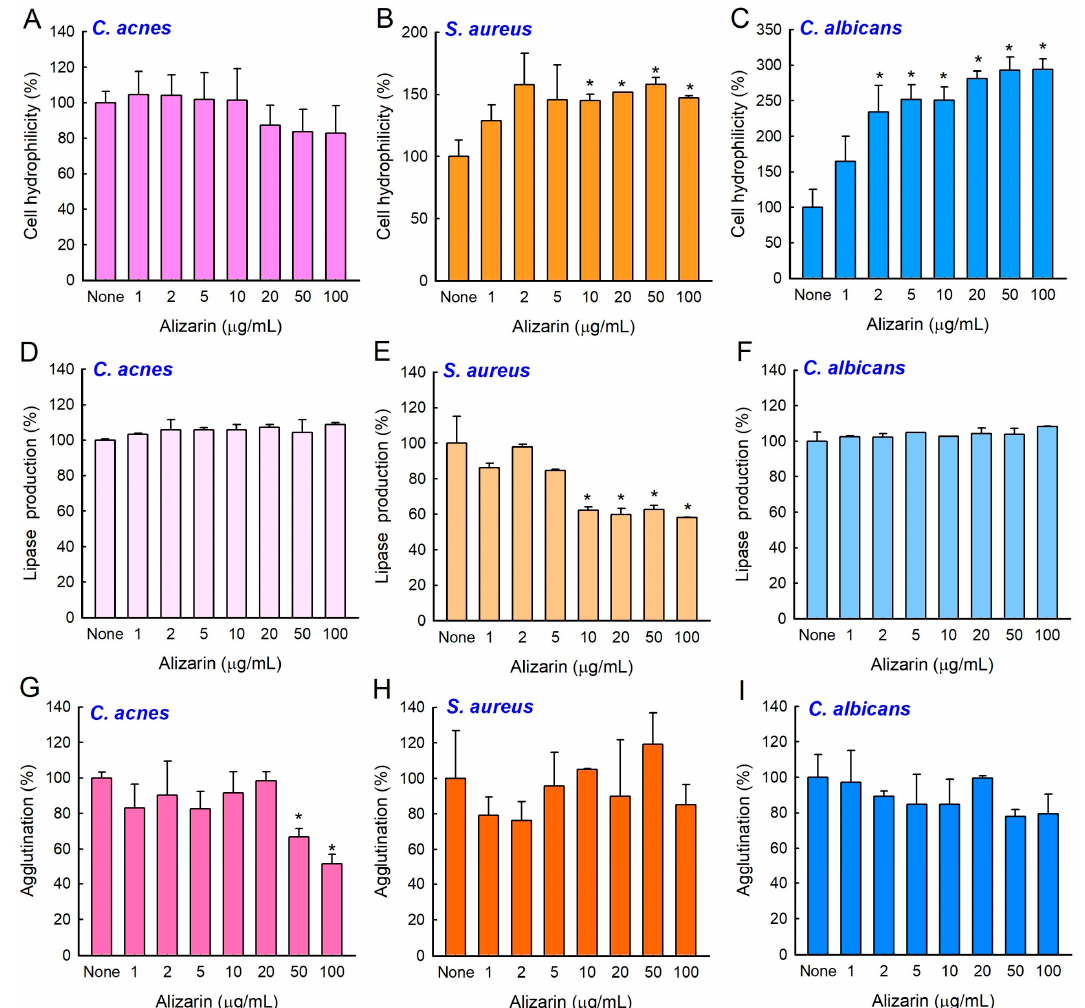
Figure 4. Effects of alizarin on virulence factors. Cell surface hydrophobicities of C. acnes , ( A ) S. aureus , ( B ) and C. albicans , ( C ) extracellular lipase production by C. acnes , ( D ) S. aureus , ( E ) and C. albicans , ( F ) cell agglutination by C. acnes , ( G ) S. aureus , ( H ) and C. albicans , ( I ) Error bars indicate standard deviations. * p < 0.05 vs. non-treated controls (None).